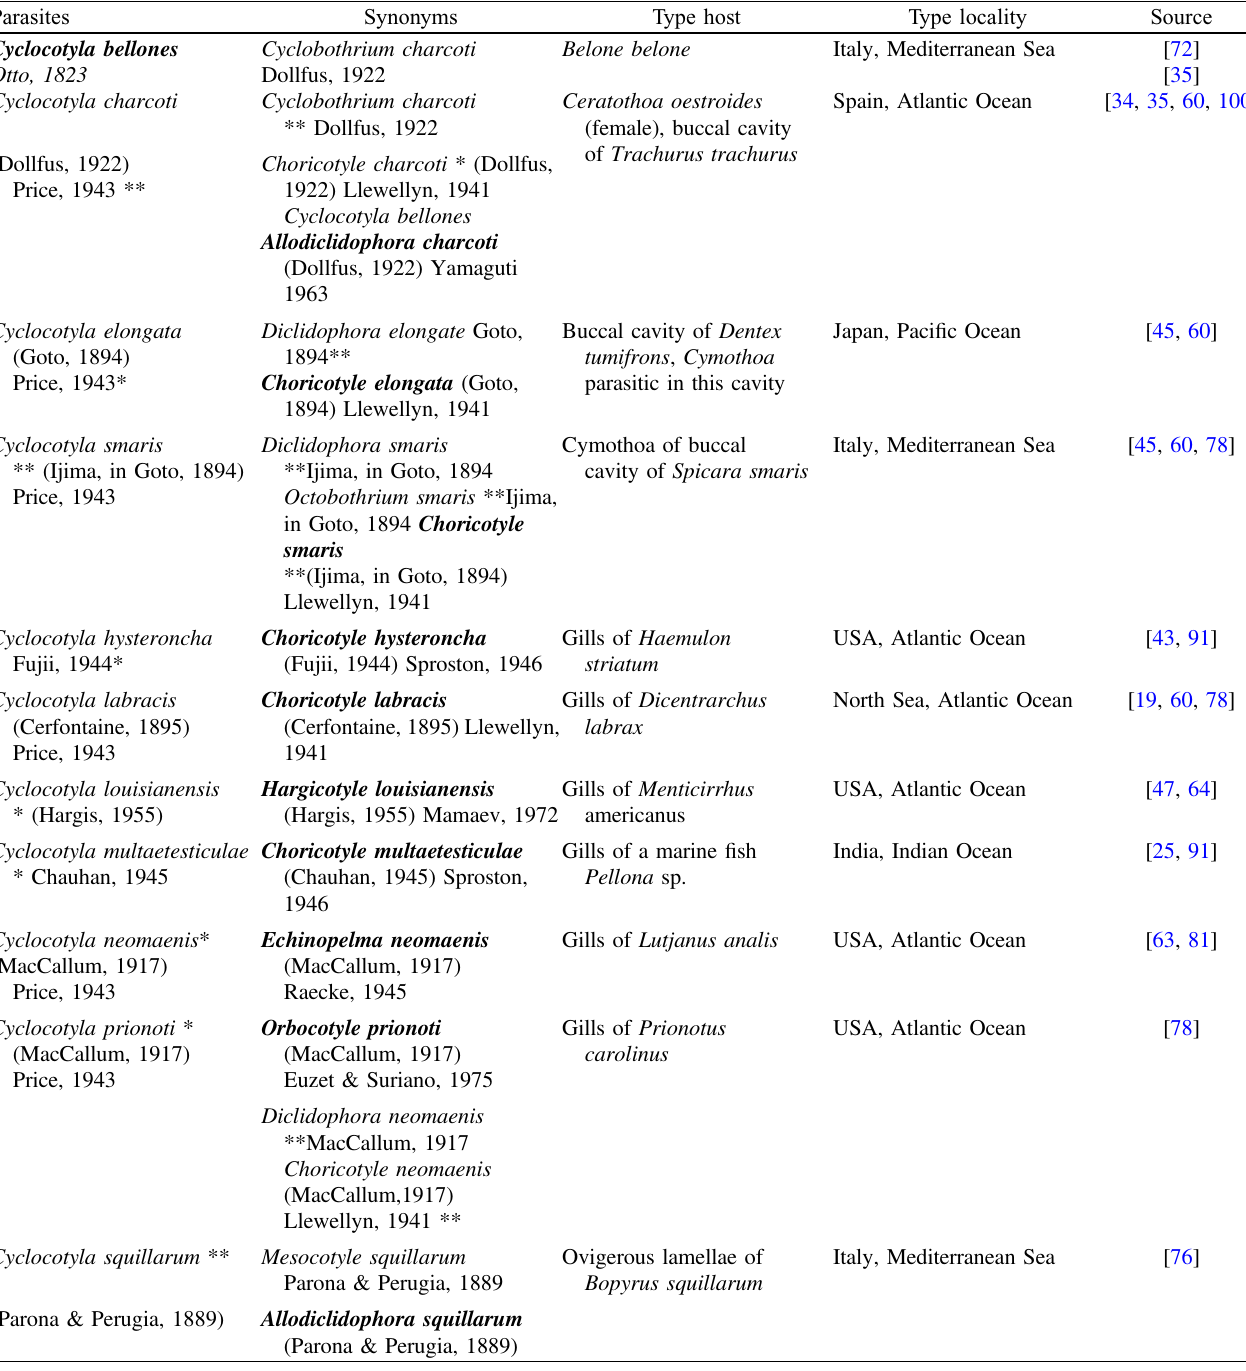
Table 5. Combinations, hosts and localities of Cyclocotyla spp. in the literature. The current combination is in bold.